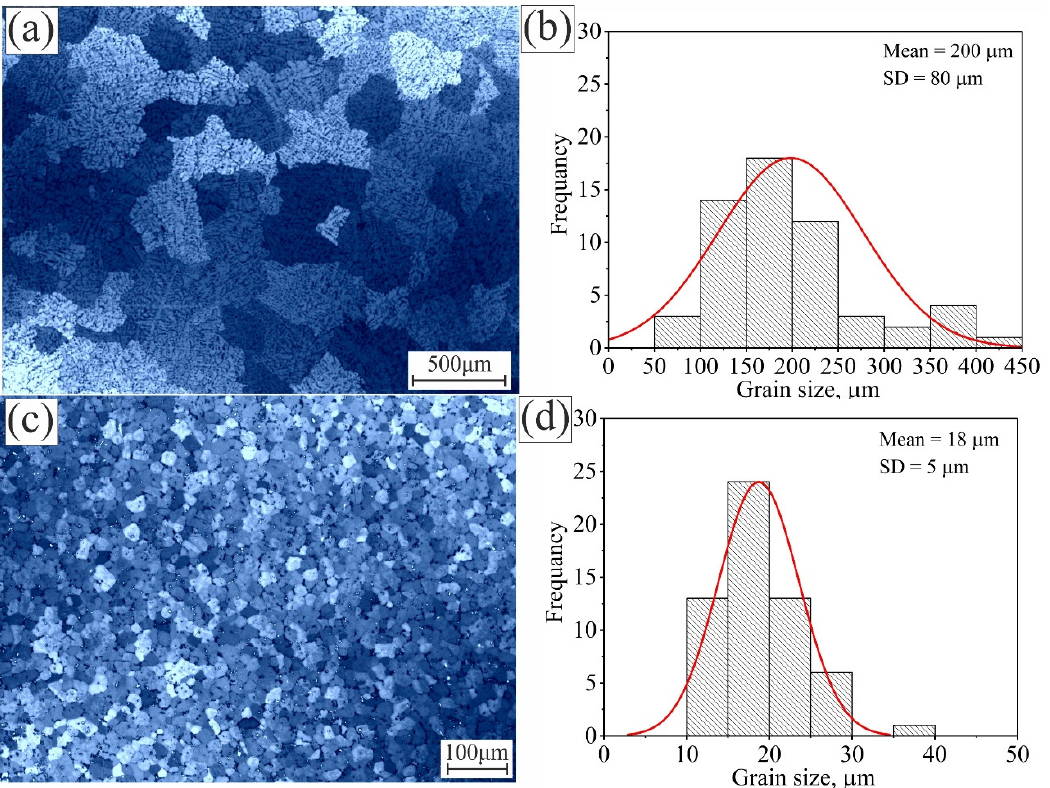
Figure 2. The as-cast microstructure and grain size distribution for ( a , b ) Al 5052 and ( c , d ) Al